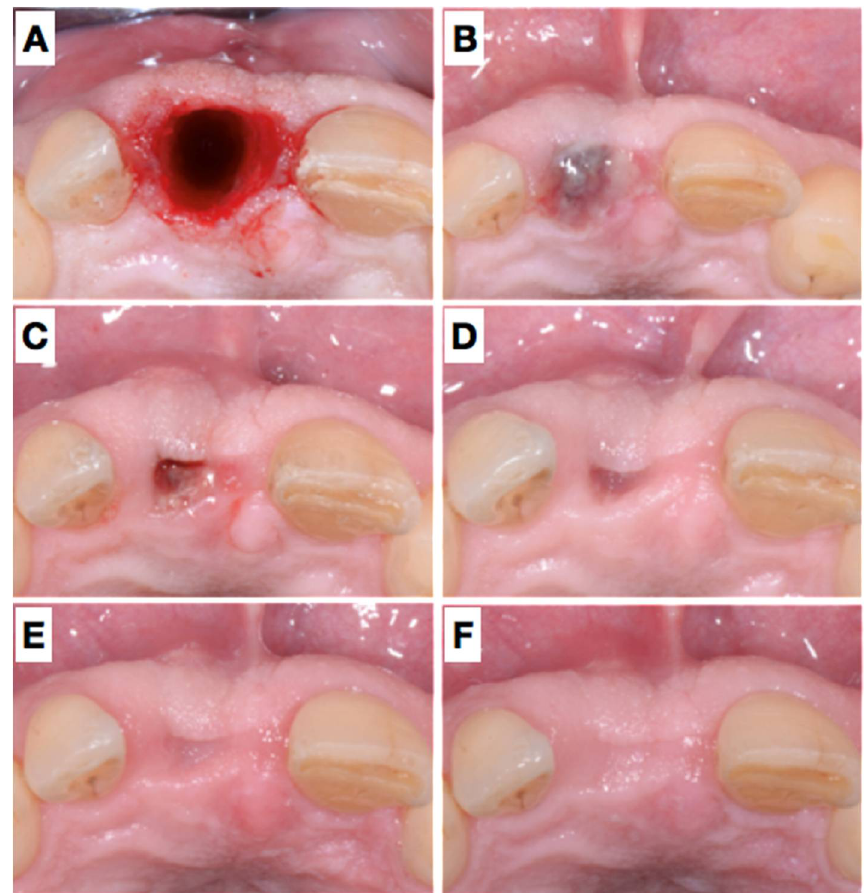
Figure 2. Post-operative images immediately after extraction and placement of the membranes ( A ) and after 3 days ( B ), 11 days ( C ), 4 weeks ( D ), 7 weeks ( E ) and 7 months ( F ). Please note the minute changes of the buccal contour and good coronal tissue closure.